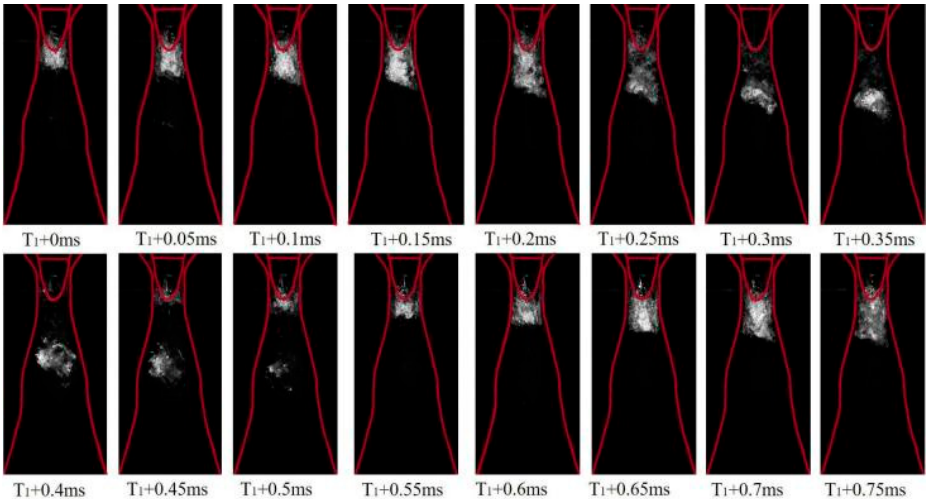
Figure 5. Quasi-periodic behavior of cavitation flow while P in = 4.5 MPa, P out = 1.0 MPa and the open- ing is 30%. opening is